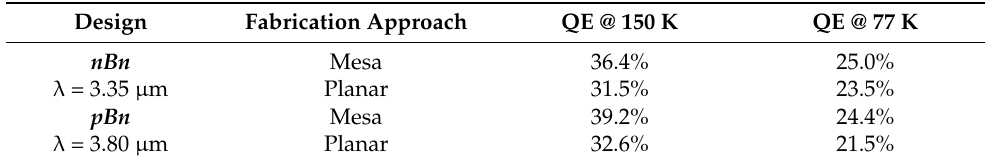
Table 3. Comparison of the D * values for planar and mesa-etched SLS devices at 77 and 150 K. (V b = − 40 mV for pBn and V b = − 80 mV for nBn ).